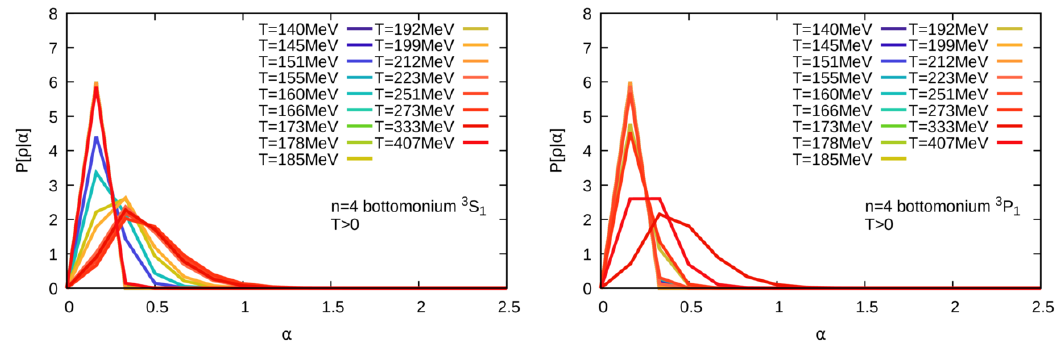
Figure 33 . Representative examples of the probability distribution over the hyperparameter (cid:11) used in the self consistent determination of the most probable spectrum at (cid:12)nite temperatures. We show here bottomonium results, the left panel contains the S-wave results, the right panel the P-wave channel.